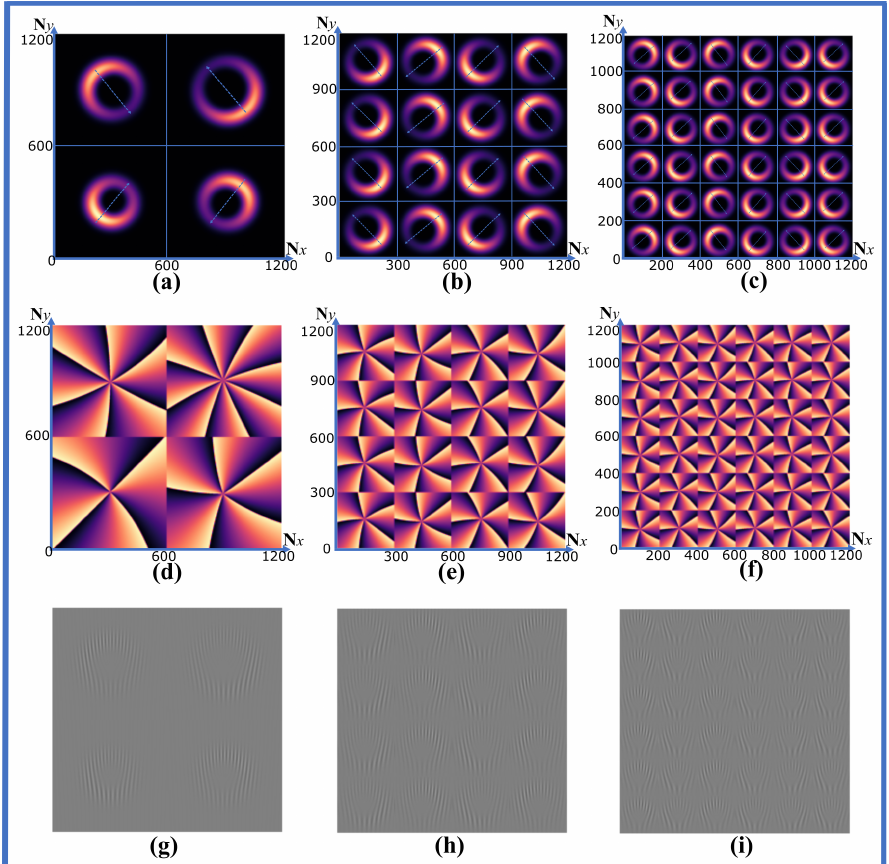
Figure 3. Simulated intensity (First row), phase profile (second row) and CGH (third row) of asymmetric LG beams array of size ( a , d , g ) 2 × 2, ( b , e , h ) 4 × 4 and ( c , f , i ) 6 × 6 for different values of x 0 , y 0 , p , and l